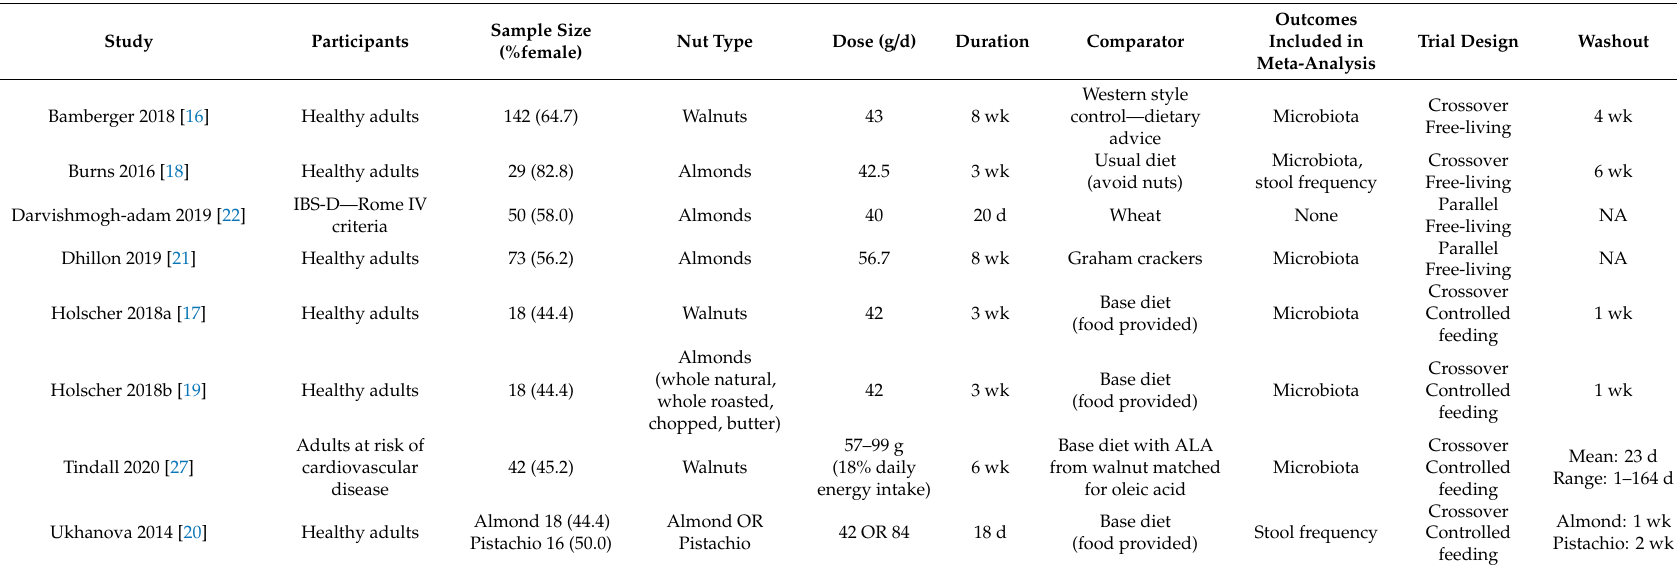
Table 2. Characteristics of randomised controlled trials investigating the impact of nut consumption on gut health 1 .